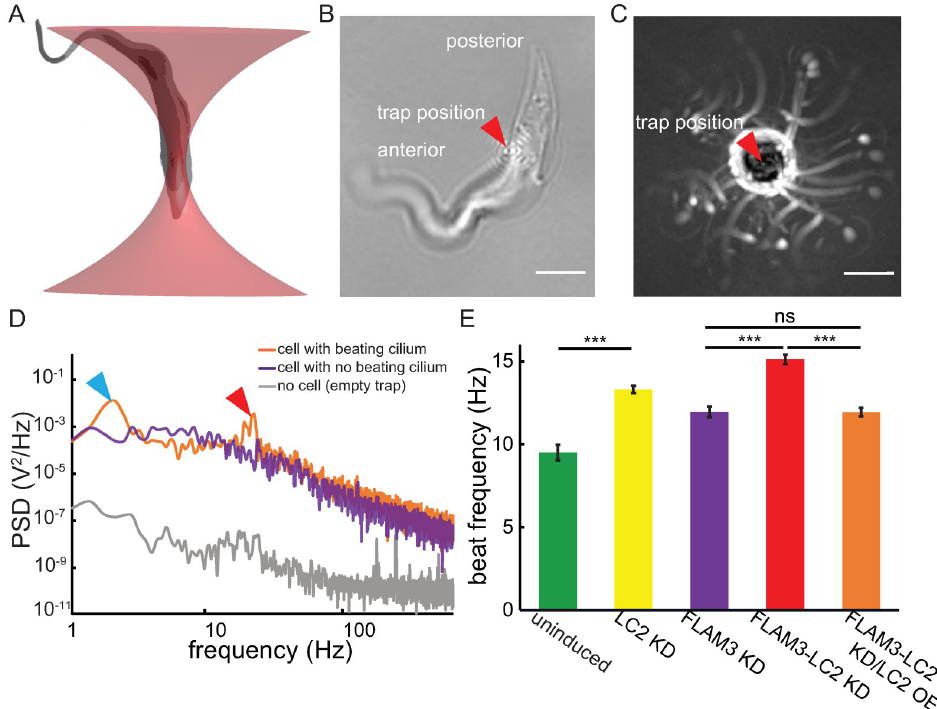
Fig 5. Optically trapped LC2 KD and FLAM3-LC2 KD cells showed upregulated ciliary beat frequency. A . Schematic of a T . brucei cell ( gray ) trapped by a low power (~20 mW) optical tweezer ( red ). B . Brightfield image of an uninduced FLAM3-LC2 KD cell taken near the coverslip, thus enabling direct visualization of the trap location and aligning the cell in the imaging plane. The identified trap location on a trypanosome cell ( red arrowhead ) is typical of all cells we trapped. Scale bar = 5 μ m. C . Typical maximum projection (intensity inverted) of a movie (2 s) showing a trapped FLAM3 KD cell as it rotates about the trap center ( red arrowhead ). Scale bar = 5 μ m. D . Typical power spectral densities (PSD) of a trapped cell with its cilium beating (FLAM3-LC2 KD/LC2 OE cell, orange ), a trapped cell with its cilium not beating (FLAM3-LC2 KD/LC2 OE cell stalled at the bottom of the imaging chamber, purple ), and background trap noise ( gray , about six orders of magnitude smaller than the PSD of the cell with a beating cilium at the beat frequency). Peaks in the PSD represent the characteristic cell rotation rate ( blue arrowhead ) and ciliary beat frequency ( red arrowhead ). Each PSD represents the average of 3 spectra (1 second of data, each). E . Ciliary beat frequency, f ω , of multiple cell lines obtained from the higher of the two characteristic frequencies from the PSD analysis. The error bars represent the SEM and ��� represents p -values < 0.0001 and ns represents p-values > 0.05 from two-tailed paired t -tests. N = 25, 86, 75, 85, and 96 for uninduced, LC2 KD, FLAM3 KD, FLAM3-LC2 KD, and FLAM3-LC2 KD/LC2 OE cells,